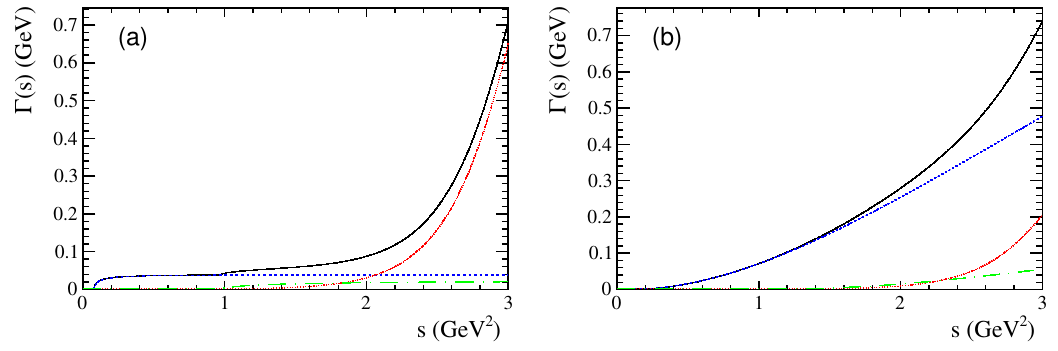
Figure 14 . Energy-dependent width for the f 0 (1370) (a) and f 2 (1270) (b) resonances. The total width is shown in black (solid), while the partial widths into the channels (cid:25)(cid:25) , (cid:25)(cid:25)(cid:25)(cid:25) and KK + (cid:17)(cid:17) are shown in blue (dashed), red (dotted) and green (dashed-dotted), respectively.